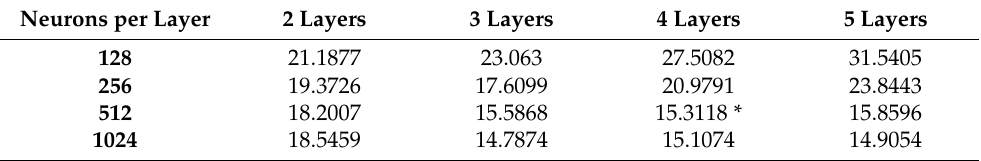
depth and neuron count generally improves overall